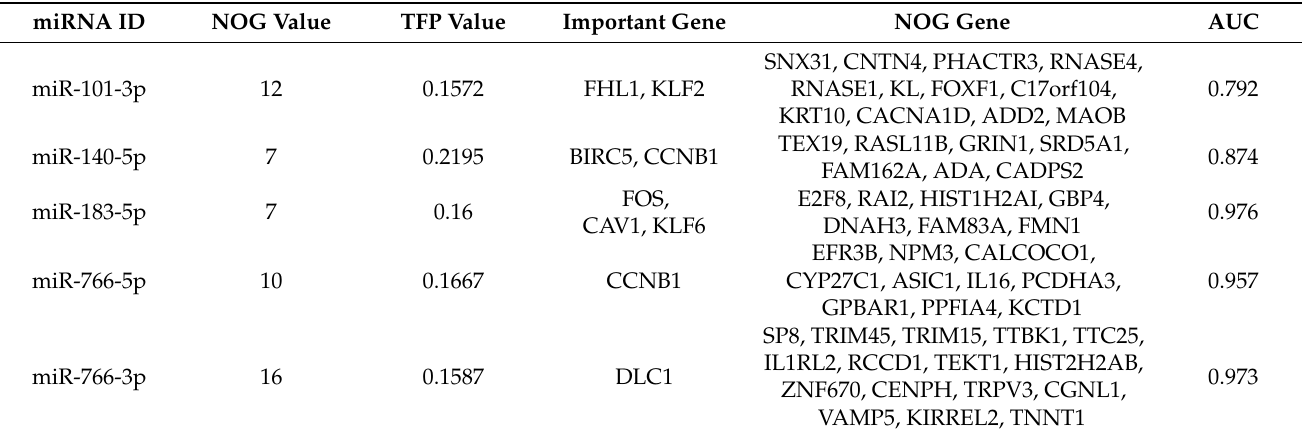
Table 2. MiRNAs obtained from the intersection of two screening methods in LUSC.